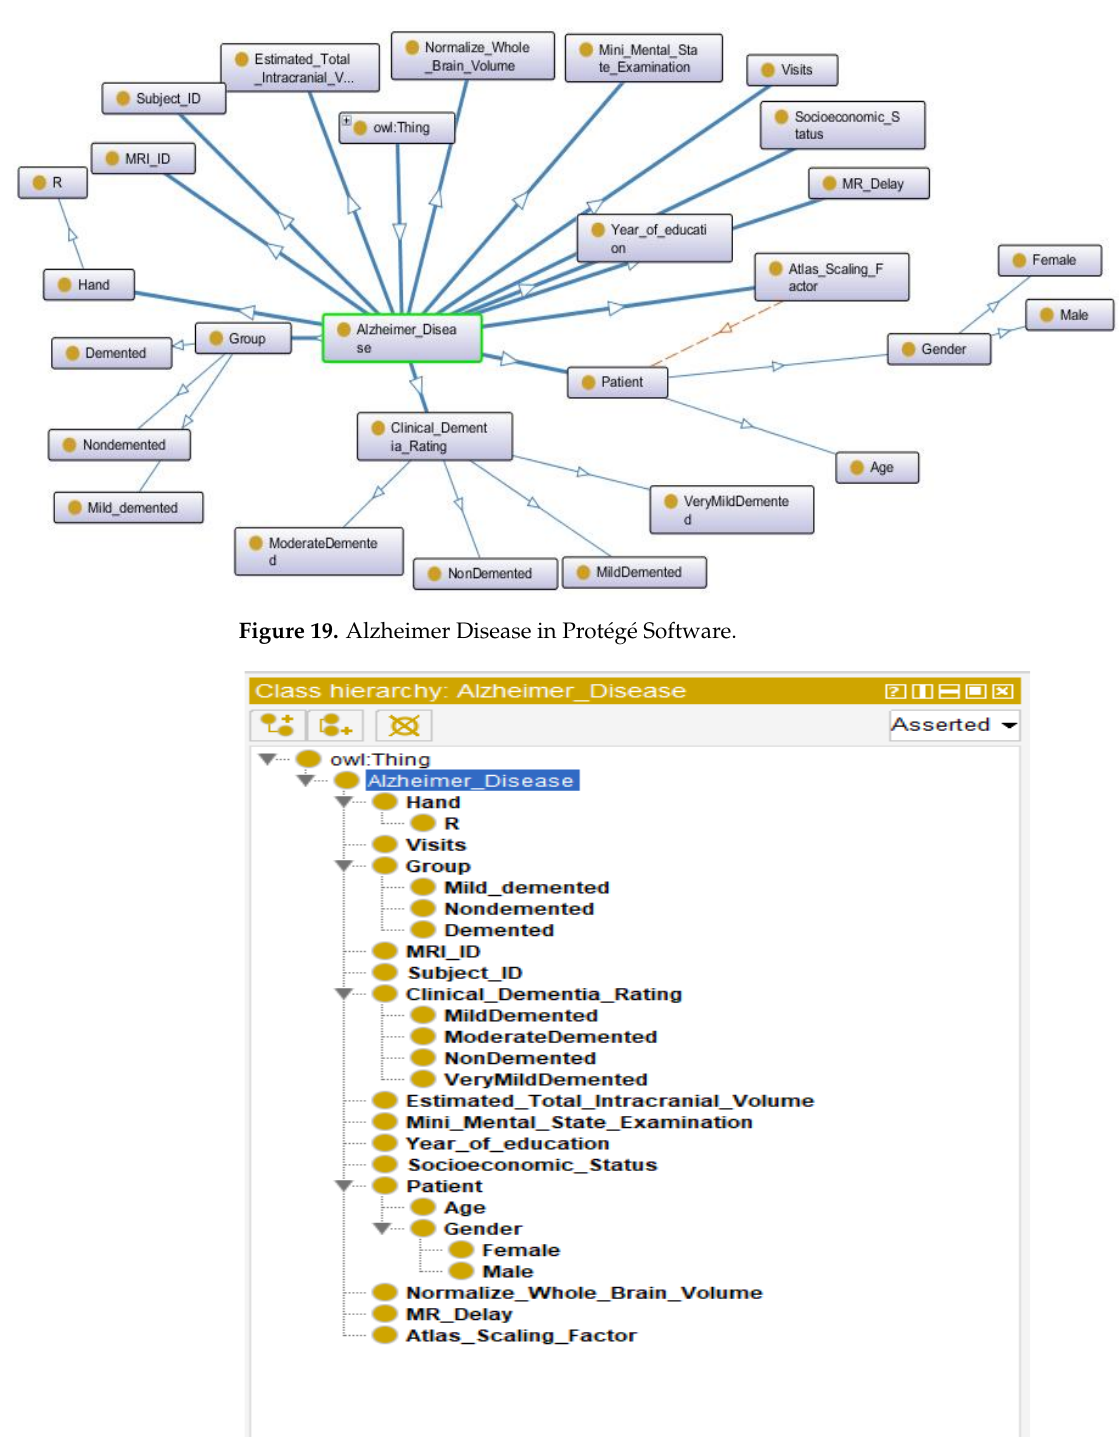
18 of 21 Table 7. Comparison of DL with State of Art . Model